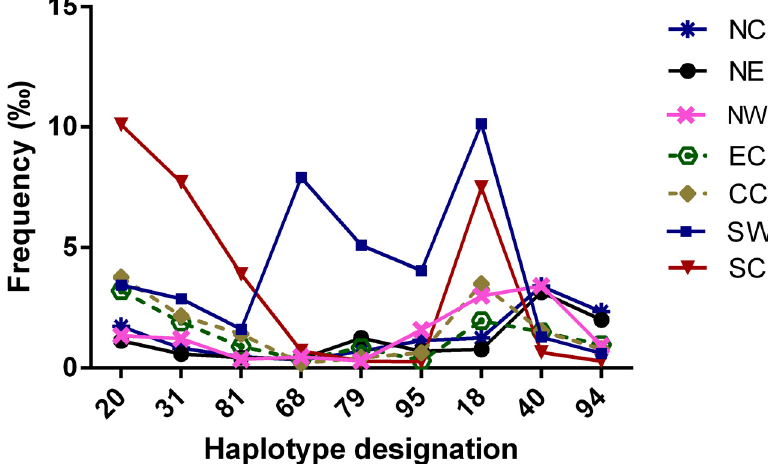
Fig 3. Distinctive HLA five-locus haplotypes in Southwest China and South